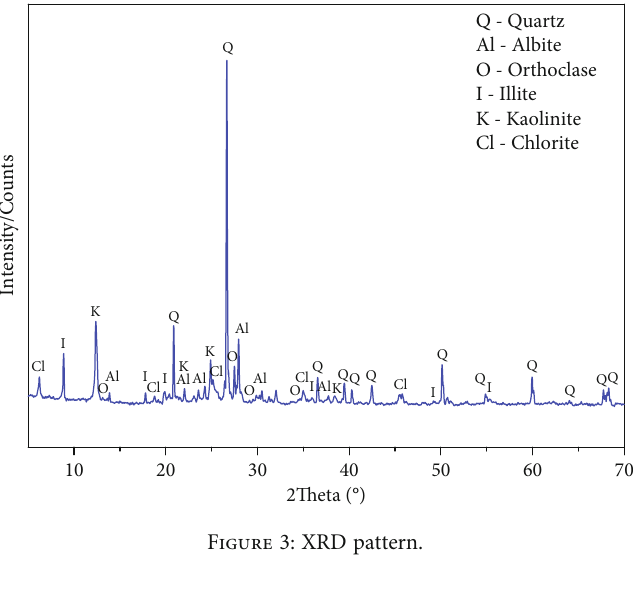
Figure 3: XRD pattern.